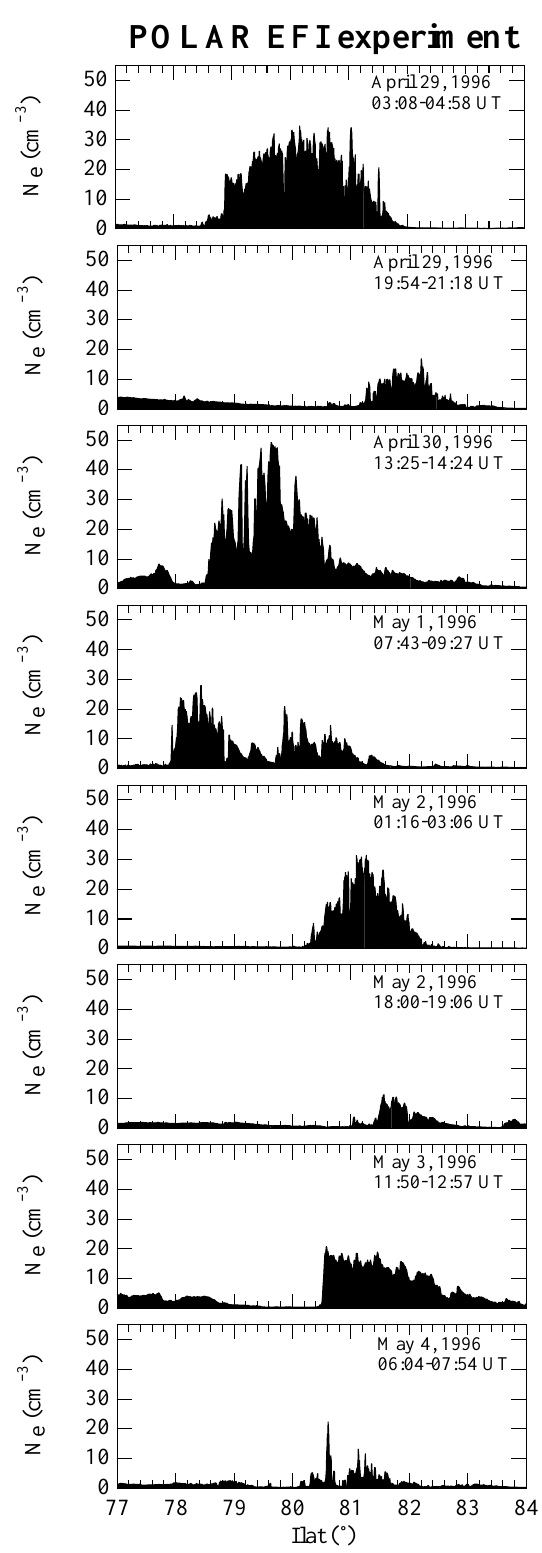
Fig. 5. Electron density is plotted against invariant latitude for the Northern Hemisphere cusp crossings of Fig.